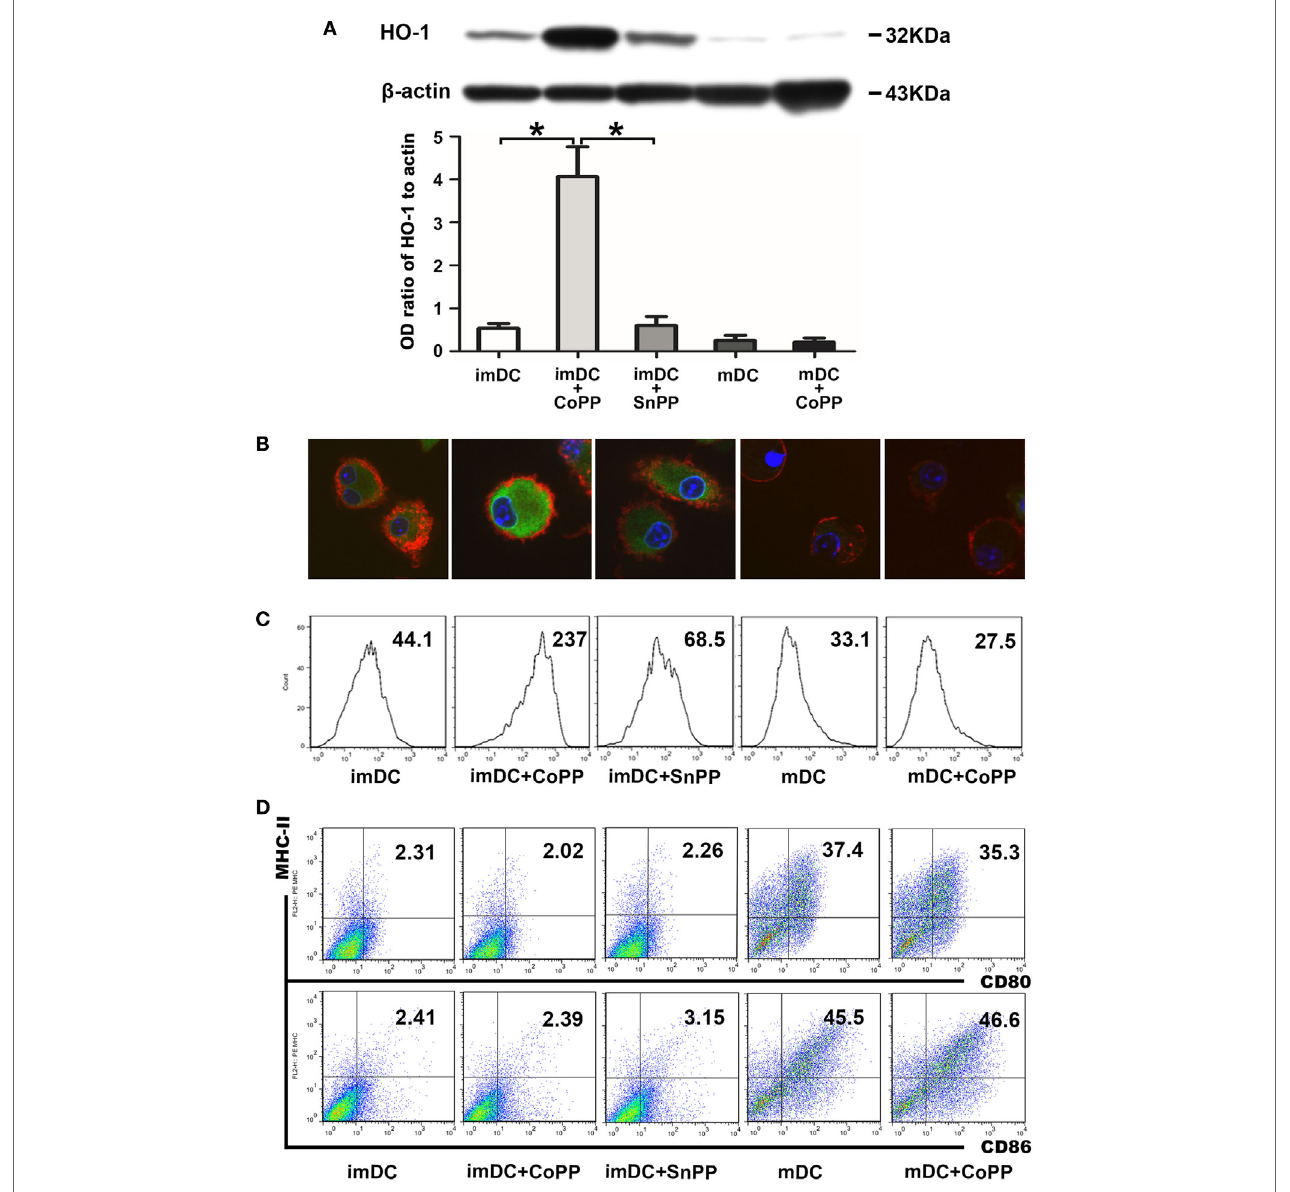
FigUre 1 | Cobalt protoporphyrin (CoPP) treatment induces HO-1 high expression in BM-derived immature dendritic cells (imDCs). Untreated, CoPP- pretreated, or SnPP-pretreated imDCs and untreated or CoPP-pretreated mDCs were used in the experiments. (a) HO-1 expression was measured by Western blotting. Anti- β -actin was used as a loading control. The corresponding densitometric analyses are shown as bar graphs. The mean ± SD is reported (* P < 0.05, n = 3 per group). (B) Immunofluorescent staining of HO-1 was performed on each group of dendritic cells (DCs). Confocal images shown are representative of three experiments with similar results (original magnification, 600 × ; red, CD11c; green, HO-1; blue, nuclei). (c) Flow cytometry analysis of HO-1 was performed on each group of DCs. Gmean values are shown. Similar results were obtained in three independent experiments. (D) The phenotype (MHC-II, CD80, and CD86) of each group of DCs was analyzed by flow cytometry. The results shown here are representative of three independent